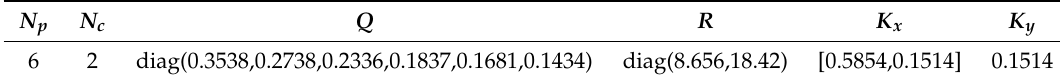
Table 2. Main parameters used to generate the desired closed-loop poles (at α 1,2 < 1 e − 5). N p N c Q R K x K y 6